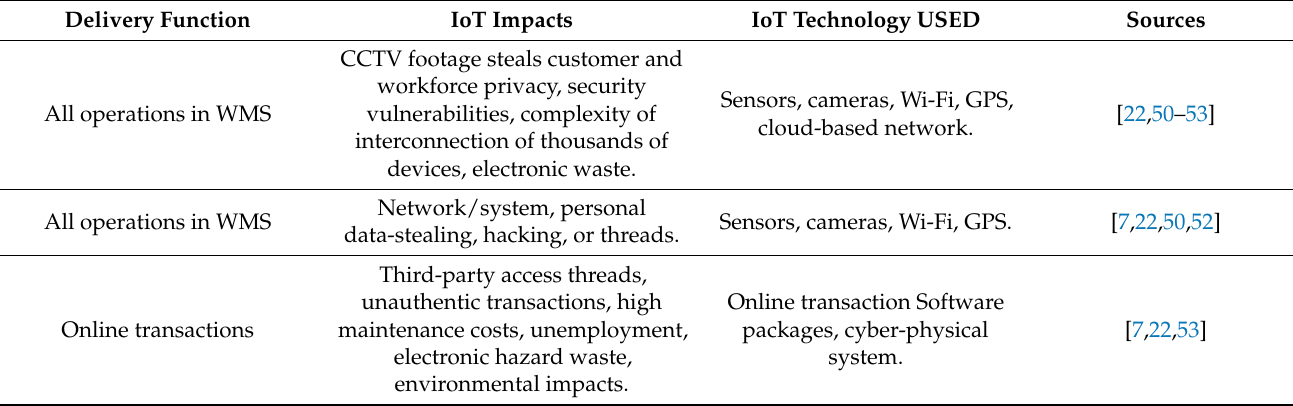
Table 3. Negative aspects of IoT integration in warehouse